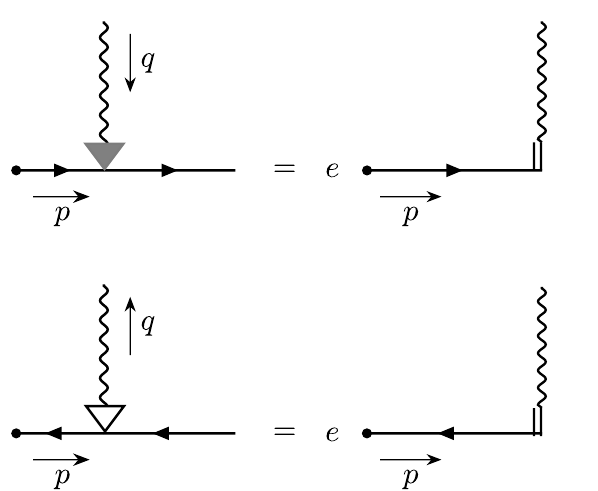
Figure 4. A pictorial representation of the effect of attaching scalar-polarized photons to external fermion lines in eqs. (3.21)–(3.22). The dots represent external fermion legs.